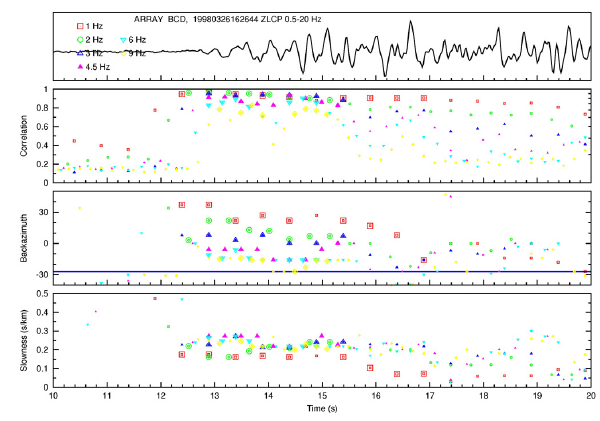
Figure 3. Results of ZLCC analysis (correlation, backazimuth and slowness) for the earthquake 19980326 1626 obtained for six differ- ent frequency bands, as shown by different symbols and colors. At the top an unfiltered seismogram recorded by station 1D is shown. The results with correlation higher than a frequency dependent threshold are shown with larger symbols. The blue line in the back- azimuth plot represent the theoretical backazimuth {